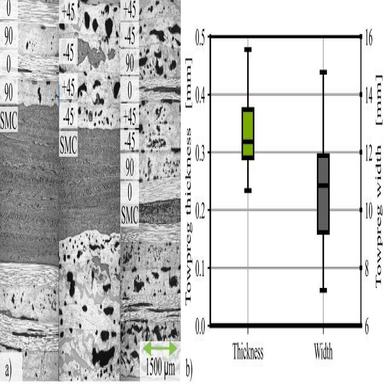
Representative optical analysis of the cross-sections of 0/90, +45/− 45 and combined towpreg design (from left to right) (a), and the box plot of determined towpreg thickness and width (b).